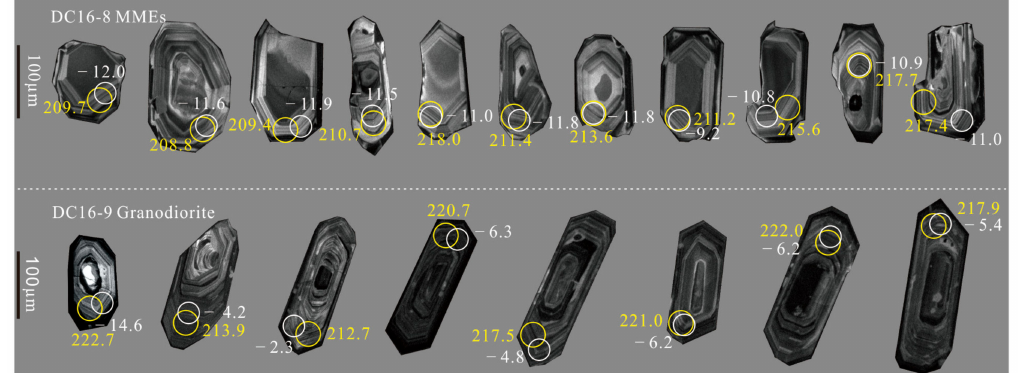
Figure 6. Cathodoluminescence (CL) images of representative zircon grains from granodiorite and MMEs. Yellow circles show the sites of laser ablation–inductively coupled plasma–mass spectrometry (LA–ICP–MS) dating, white circles show the sites of measured Hf isotopic